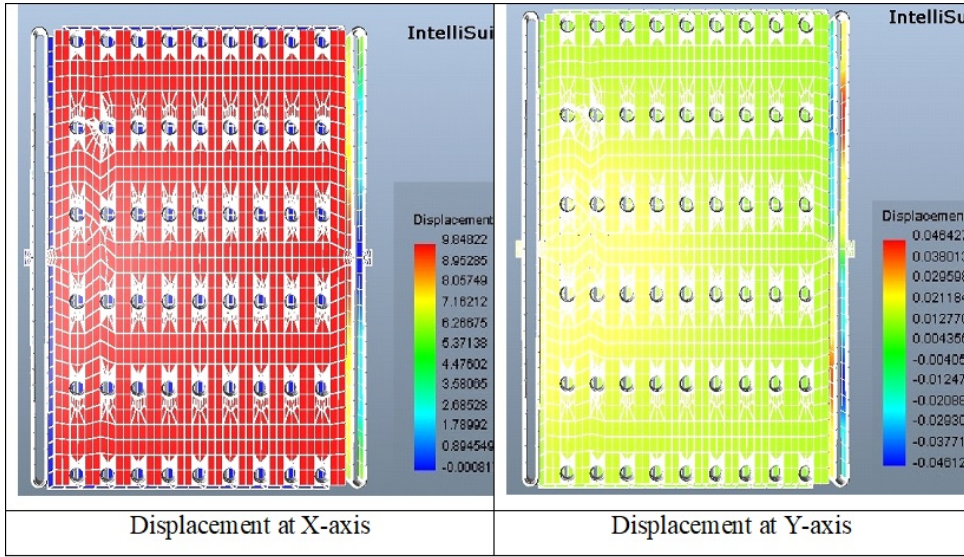
Figure 9: Optimised design displacement at 100